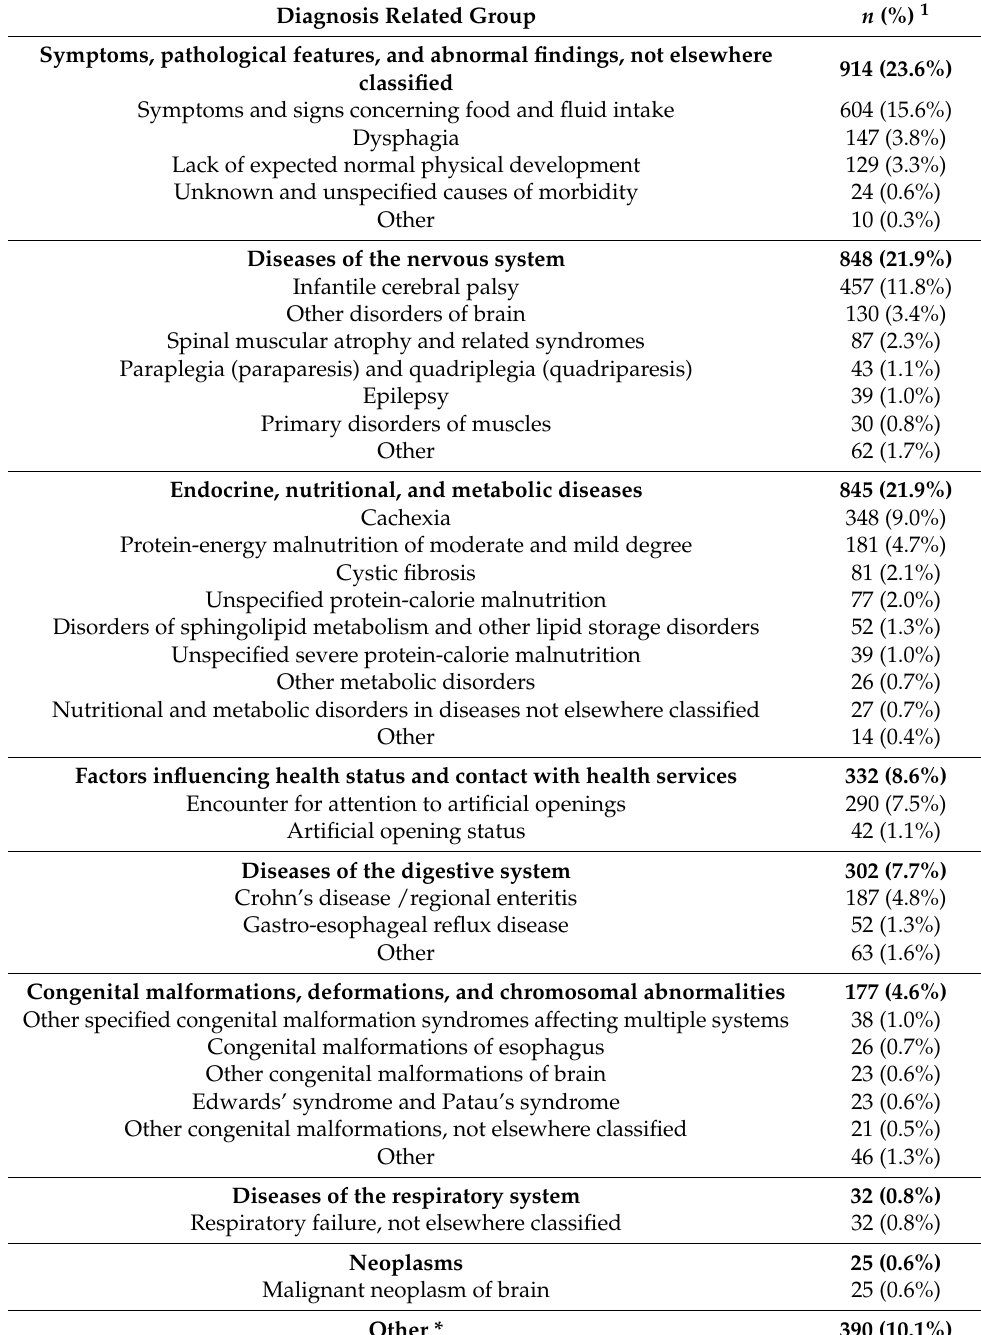
Table 2. Principal diagnoses in HEN patients by ICD-10